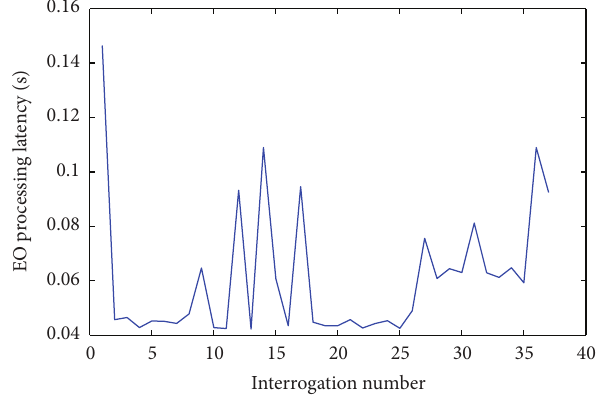
Figure 12: Image processing latency.